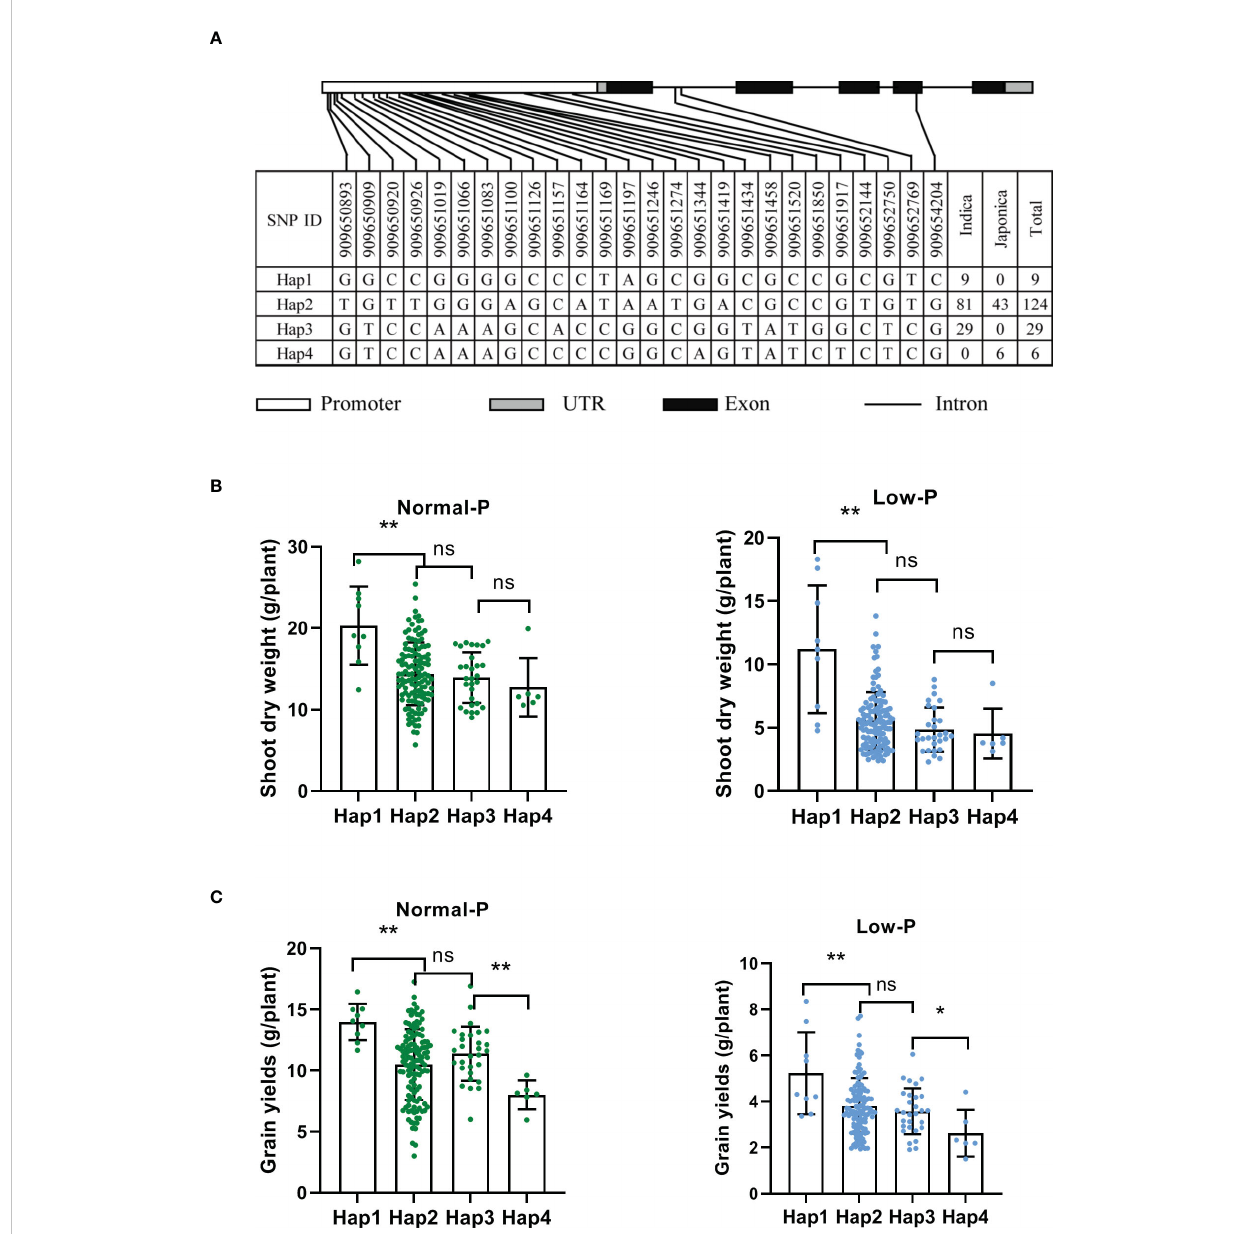
FIGURE 6 Haplotype analysis of OsAAD . (A) The gene structure of OsAAD . Four main haplotypes were detected by single nucleotide polymorphism (SNP) variations. The numbers of varieties in two subspecies of each haplotype are shown in the right column. (B, C) Shoot dry weight and grain yields per plant were compared among four haplotypes under normal and low Pi supply, respectively. All data are presented as the means ± SD. *P < 0.01; **P < 0.001, ns, not signi fi